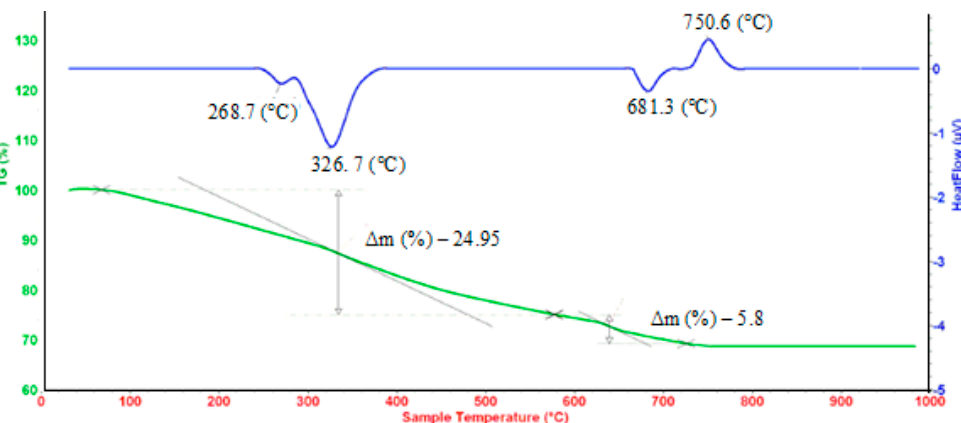
Figure 3. TGA/DSC results of the precipitate containing Nd (III) and Fe (III) (the mol ratio of Fe 3+ to Nd 3+ is 1/1).